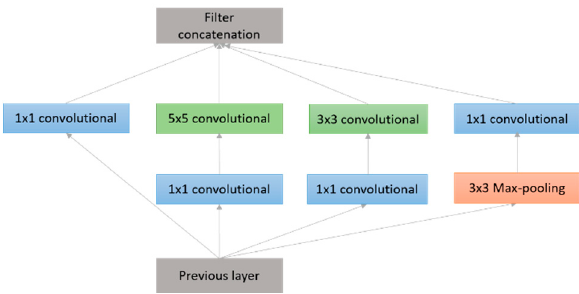
Figure 15. Inception layer with dimension reduction.